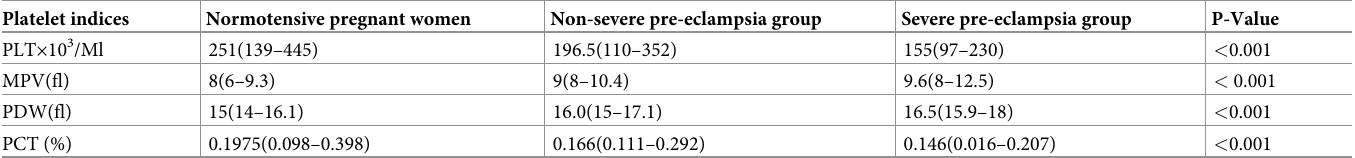
Table 3. Comparisons of platelet indices among normotensive, non-severe, and severe pre-eclamptic pregnant mothers in NEMMCSH from January 1 to April 3, 2019.